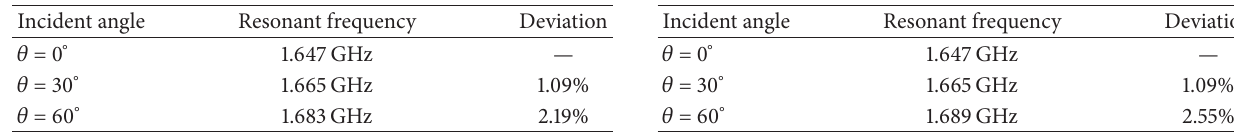
Table 4: The resonant frequency deviation of proposed FSS at TM-